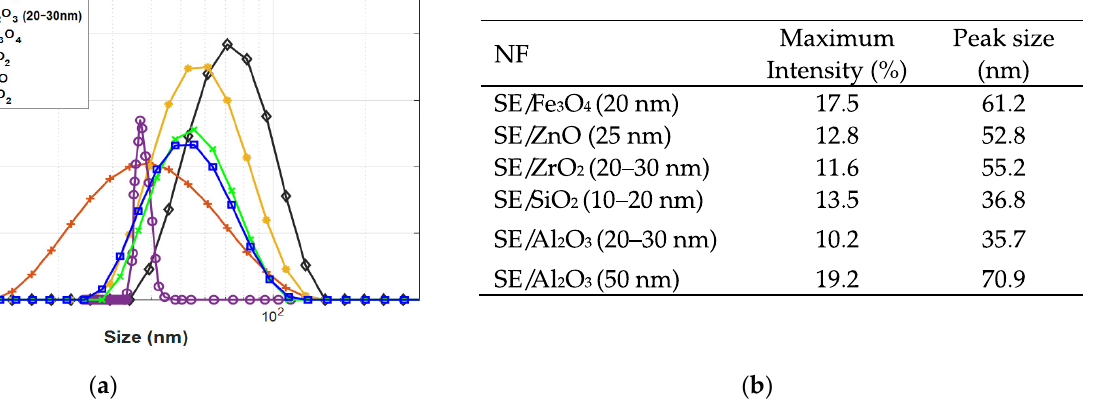
Figure 4. Nanoparticle size distribution ( a , b ).